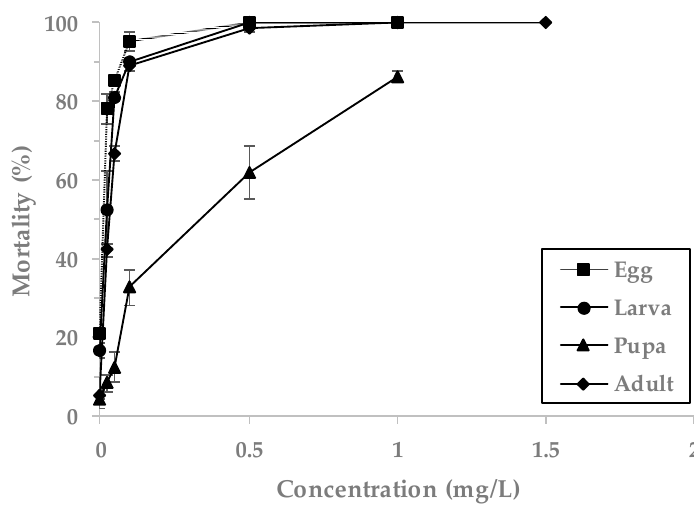
Figure 1. Mortality of L. serricorne exposed to the PH 3 fumigant for 20 h at 20 °C in a 12 L desiccator. Table 1. Lethal concentration time of L. serricorne exposed to the PH 3 fumigant.